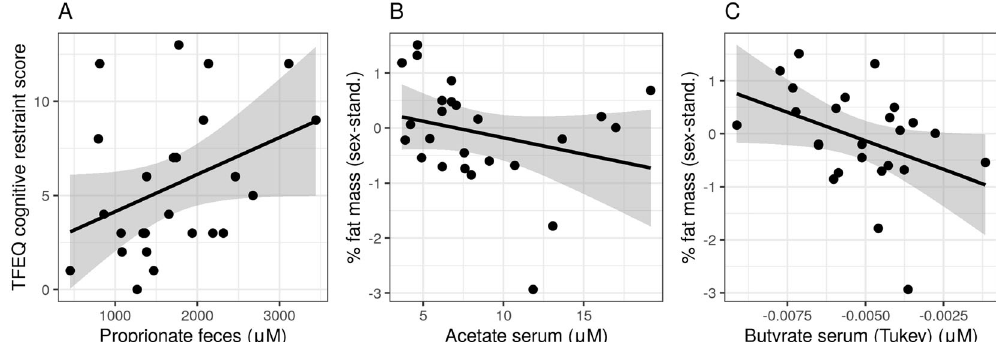
Fig. 4 SCFA levels in feces and serum are associated with eating traits and body fat mass in overweight adults (sample 1). Pearson ’ s correlations shown for fecal SCFA levels and eating trait cognitive restraint (TFEQ) (r = 0.50, p-FDR = 0.014) ( A ) and serum SCFA levels with body fat mass for acetate ( B ) and butyrate ( C ) (all r > − 0.43, all p-FDR < 0.04).